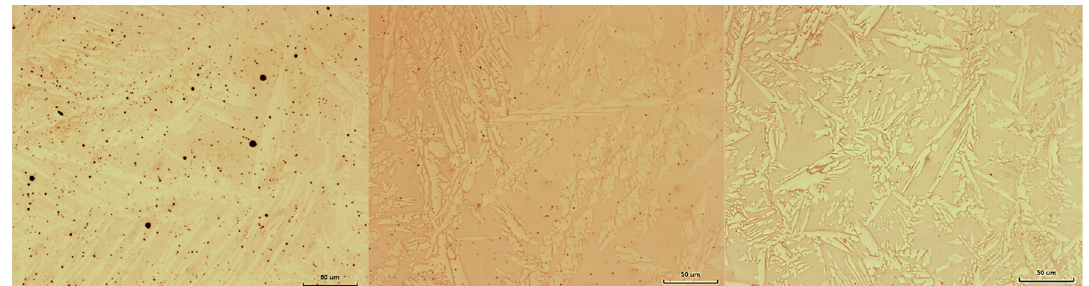
Figure 16. Oxygen content in the root and the center of the welds.